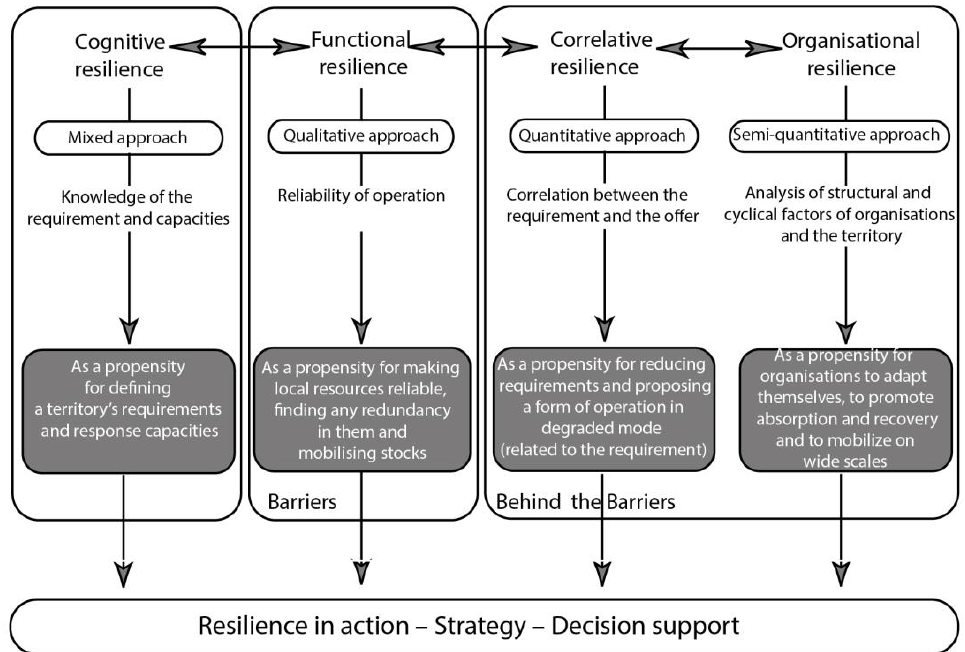
Figure 1. “Behind the Barriers” conceptual model. Source: Barroca and Serre Figure 1. “ Behind the Barriers” conceptual model. Source: Barroca and Serre [34].